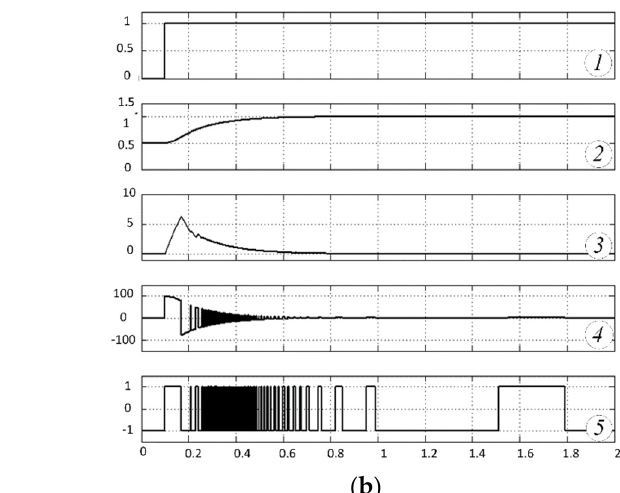
( b ) Figure 12. Logarithmic amplitude–frequency characteristics of VSS ( a ) and transient processes in the model with changed time delays while maintaining stability ( b ).1 Reference signal. 2 Adjustable value. 3 Derivative. 4 Derivative signal after a discrete link. 5 Relay element output.